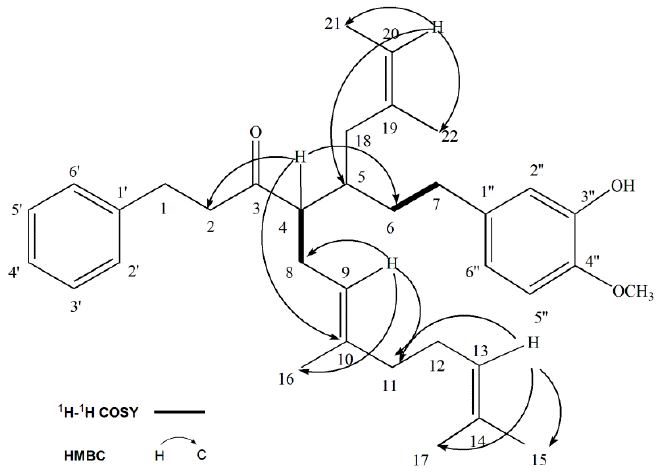
Figure 2. 1 H- 1 H COSY and key HMBC correlation of compound 3 .